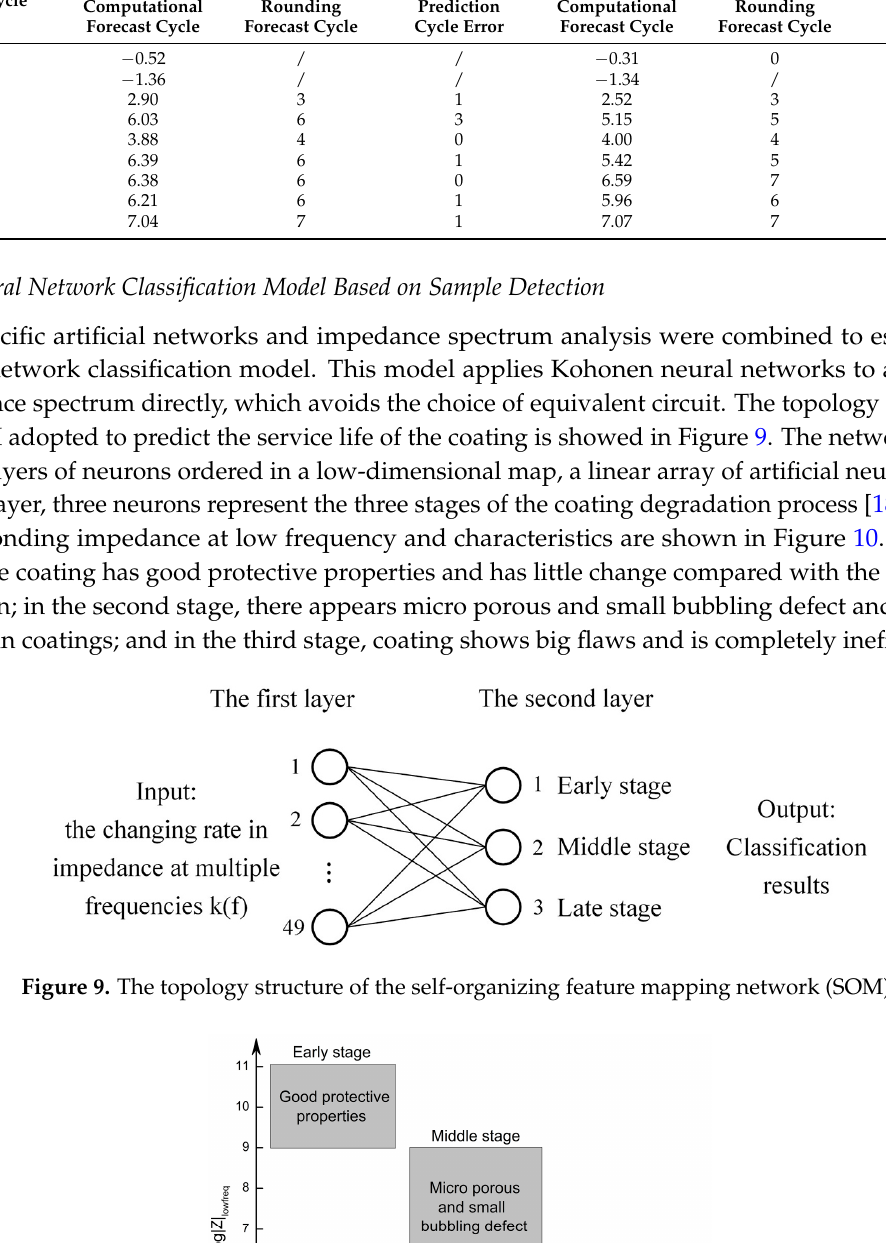
Table 2. Prediction results of improved degradation kinetics model.